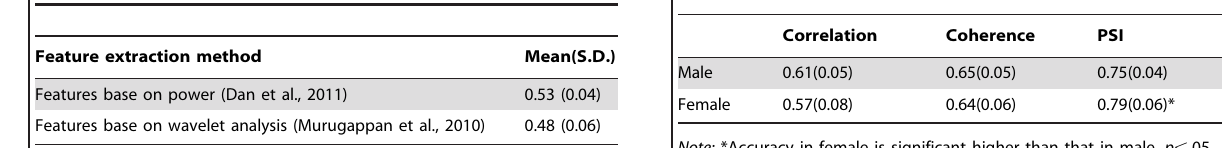
Without feature selection With feature selection